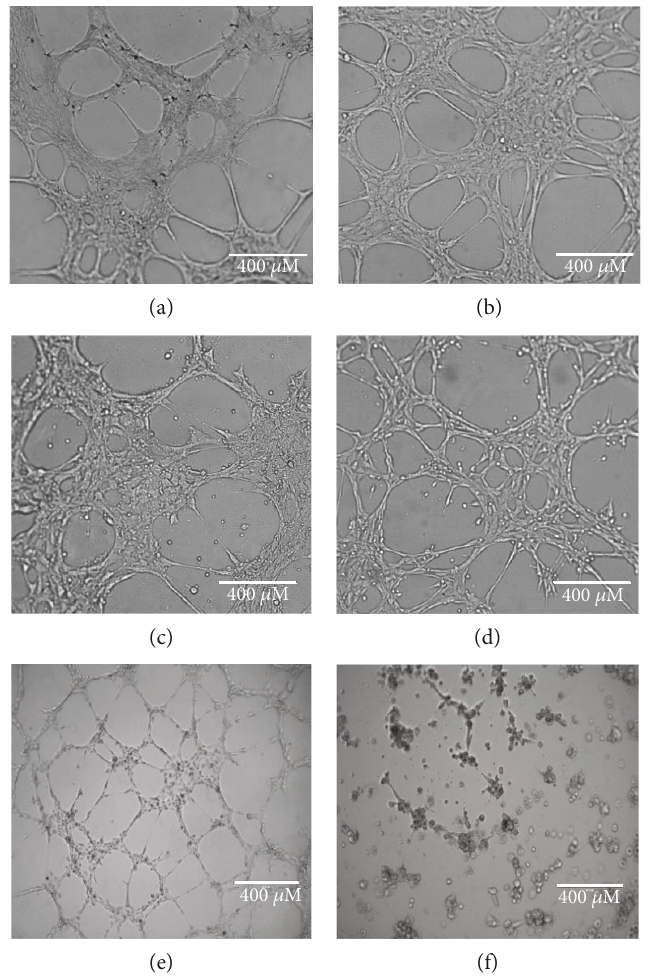
Figure 1: Angiogenic properties of pericytes. Both normal (NP-Ad, NP-Mu) and tumor-associated pericytes (TP-Nbl, TP-Epn) were capable of forming tube-like structures in vitro, generating interconnected networks similar to those generated by endothelial cells (HUVEC). Mesenchymal stem cells (MSCs) do not share this propriety and, therefore, were not able to generate such tube-like structures under the same experimental conditions. (a) NP-Ad; (b) NP-Mu; (c) TP-Nbl; (d) TP-Epn; (e) HUVEC; (f)